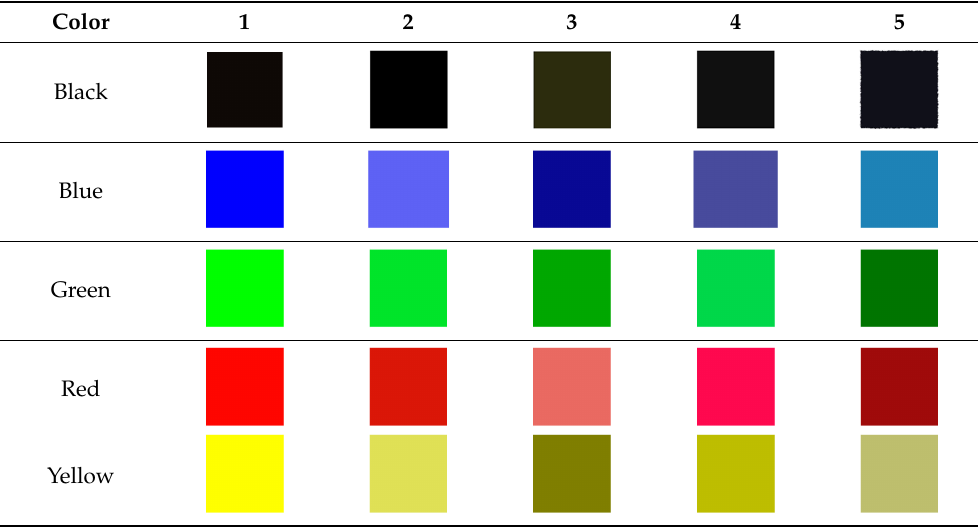
Table 1. The five introduced colors with five different shades each.